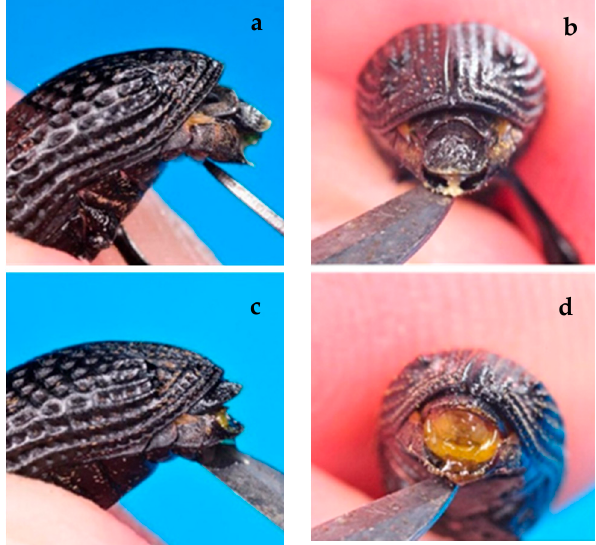
Figure 7. Abdomen of the black weevil Aclees taiwanensis with the last tergite exposed: ( a ) male lateral view, ( b ) male back view, ( c ) female lateral view, and ( d ) female back view.